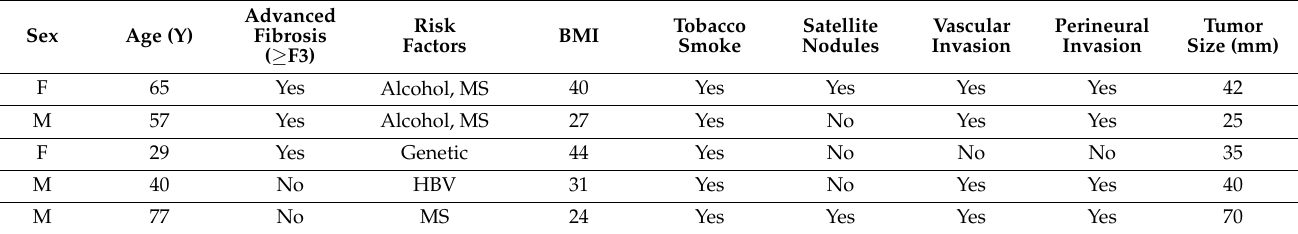
Table 1. Clinical and pathological features of patients.